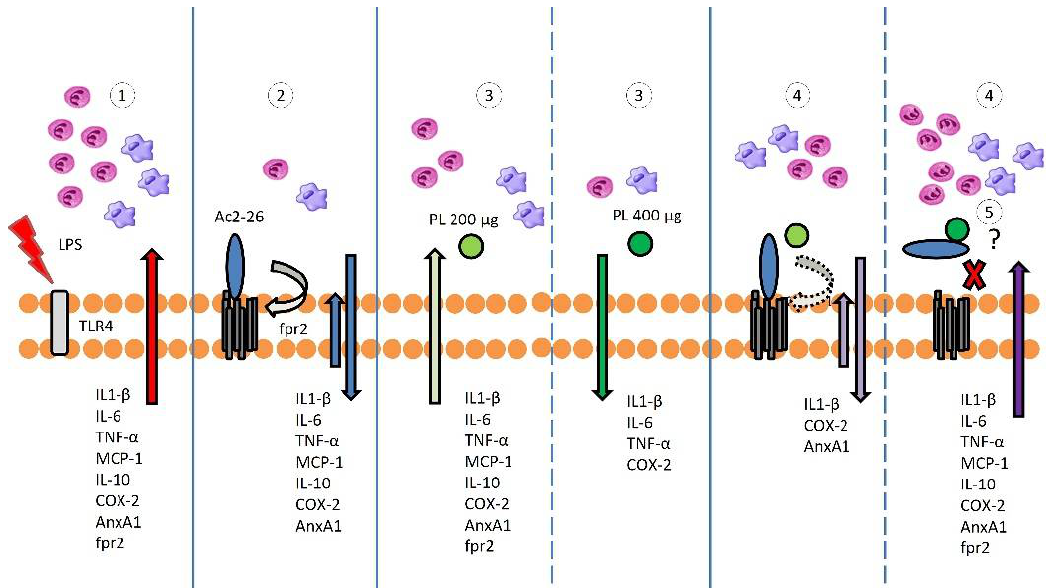
Figure 8. Schematic model of Ac2-26 and PL actions in EIU. ( 1 ) LPS triggers the release of cytokines (IL1-β, IL-6, IL-10, TNF-α, MCP-1), leukocyte influx (neutrophils and monocytes), and the production of endogenous COX-2, AnxA1, and fpr2. ( 2 ) These inflammatory responses are mitigated by Ac2-26, mediated by fpr2 receptor, and ( 3 ) PL, especially at a higher dosage. ( 4 ) The coadministration of Ac2-26 and PL abrogates the anti-inflammatory effects of the singly administered compounds. ( 5 ) Conformational changes on the Ac2-26 peptide due to its interaction with PL may impair its binding to the fpr2 receptor. Larger arrows directed upwards or downwards indicate an increase or decrease, respectively, of cytokines and endogenous proteins produced by the cell. Smaller arrows pointing upwards indicate increased expression of fpr2. Outside the cell, pink shape represents neutrophils, purple shape represents monocytes, light green circle depicts PL at 200 µg dosage, dark green circle depicts PL at 400 µg dosage, and blue oval represents Ac2-26. 5. Conclusions Our study sheds light on the protective effects of PL, revealing it as a potential ther- apeutic target in ocular inflammation. Furthermore, the results show that Ac2-26 + PL combination abrogates the anti-inflammatory actions of Ac2-26 and PL singly adminis- tered.